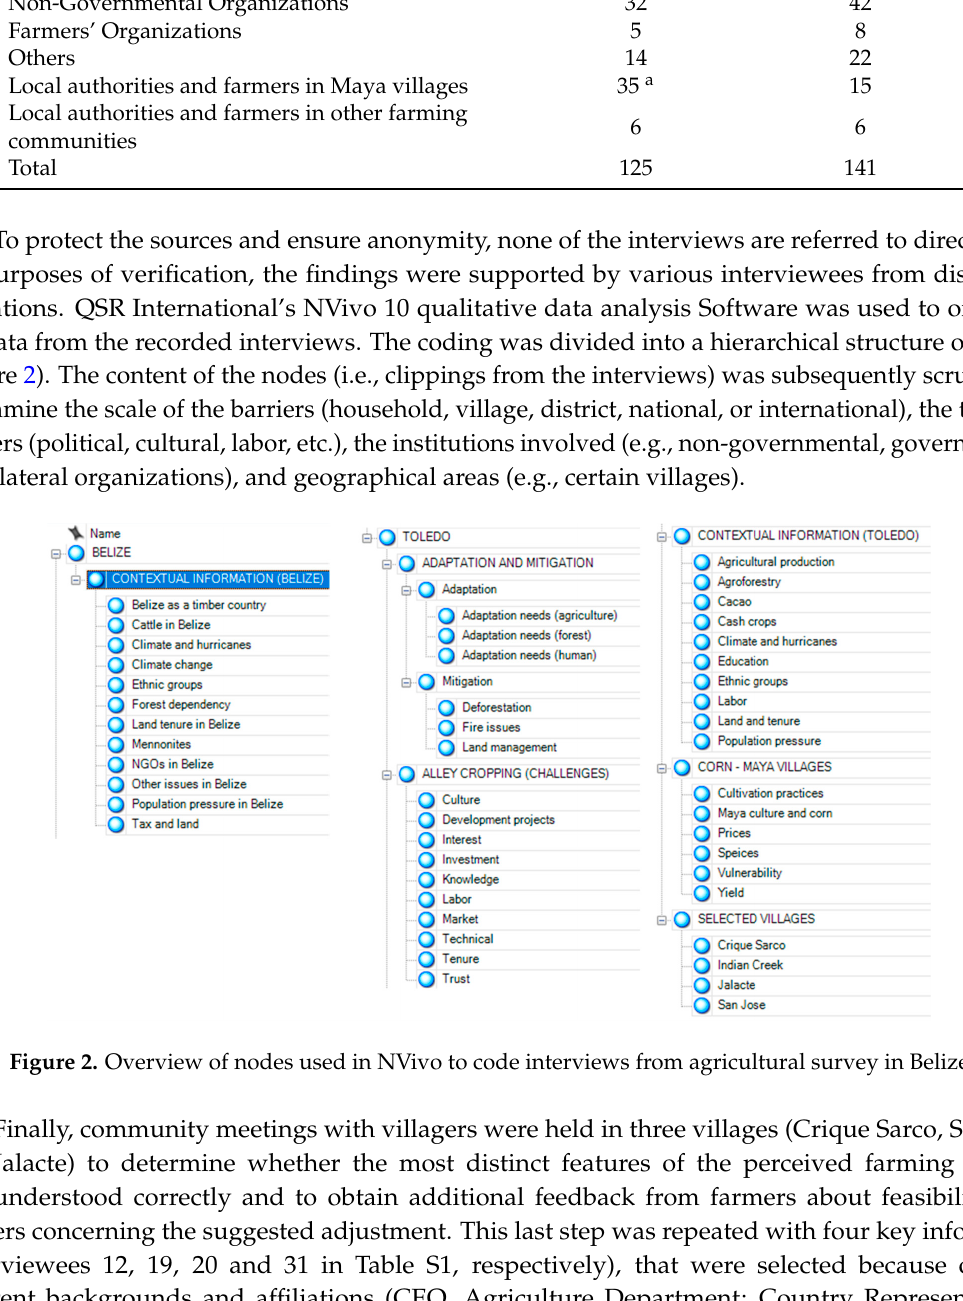
Table 1. Organizations and persons interviewed for agricultural survey in Belize (see detailed list of interviewees in Table S1). a Three community meetings are excluded from this figure.